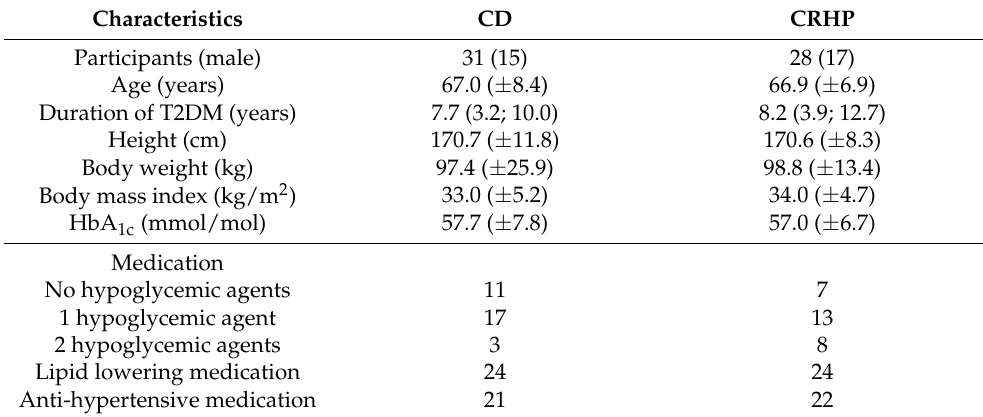
Table 1. Baseline